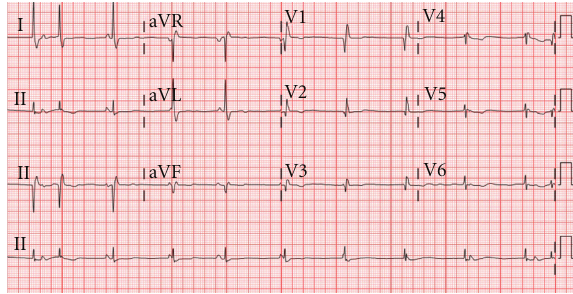
Figure 2: AV dissociation occurring after the 8th ECT session.